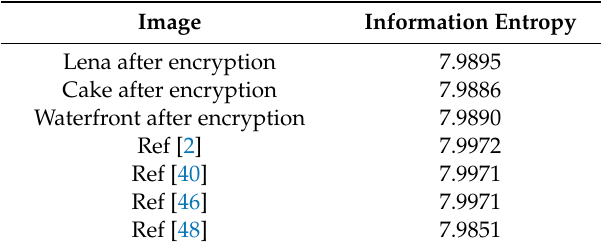
Table 3. Information Entropy